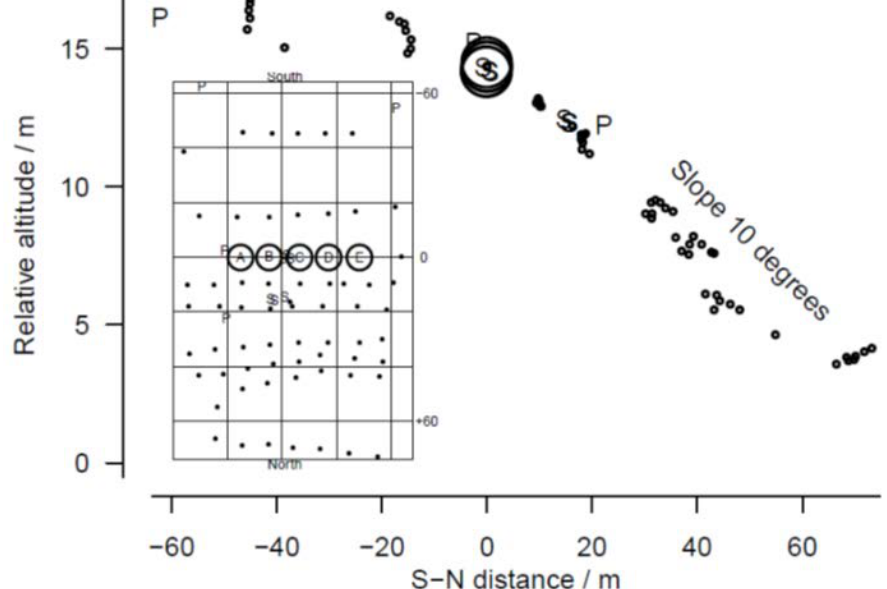
Figure 2. Topography of the experiment area on the Moor House National Nature Reserve. Origin of the E–W scale is arbitrary. S–N scale is centred on the line of injection sites. Distances to the South, across the ‘level’ ground at the top of the hill, are negative. Main graph: vertical section S–N of the experiment area, showing the 10 ° slope. (N.B. horizontal axis is S–N distance; axes have same units but scales differ.) The overlaid large circles in the centre are the injection sites. ‘P’ were remaining fence posts (in 1990); ‘S’ seepage tubes. Altitude is relative to an arbitrary local datum. Inset: horizontal projection (map), viewed from the foot of the slope, looking South. Grid is 20 m side. Tiny circles are places surveyed for the main graph (S–N profile). Large circles are injection sites 10 m apart. Site identity ‘A’ to ‘E’ inside the